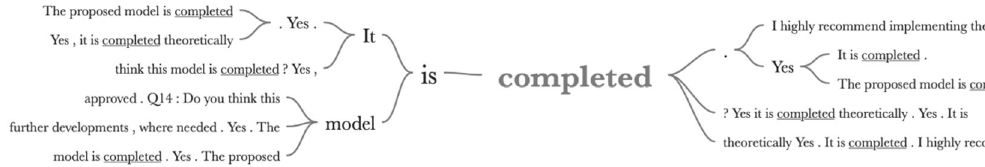
Fig. 5 Stemmed word query for “ completed ” .